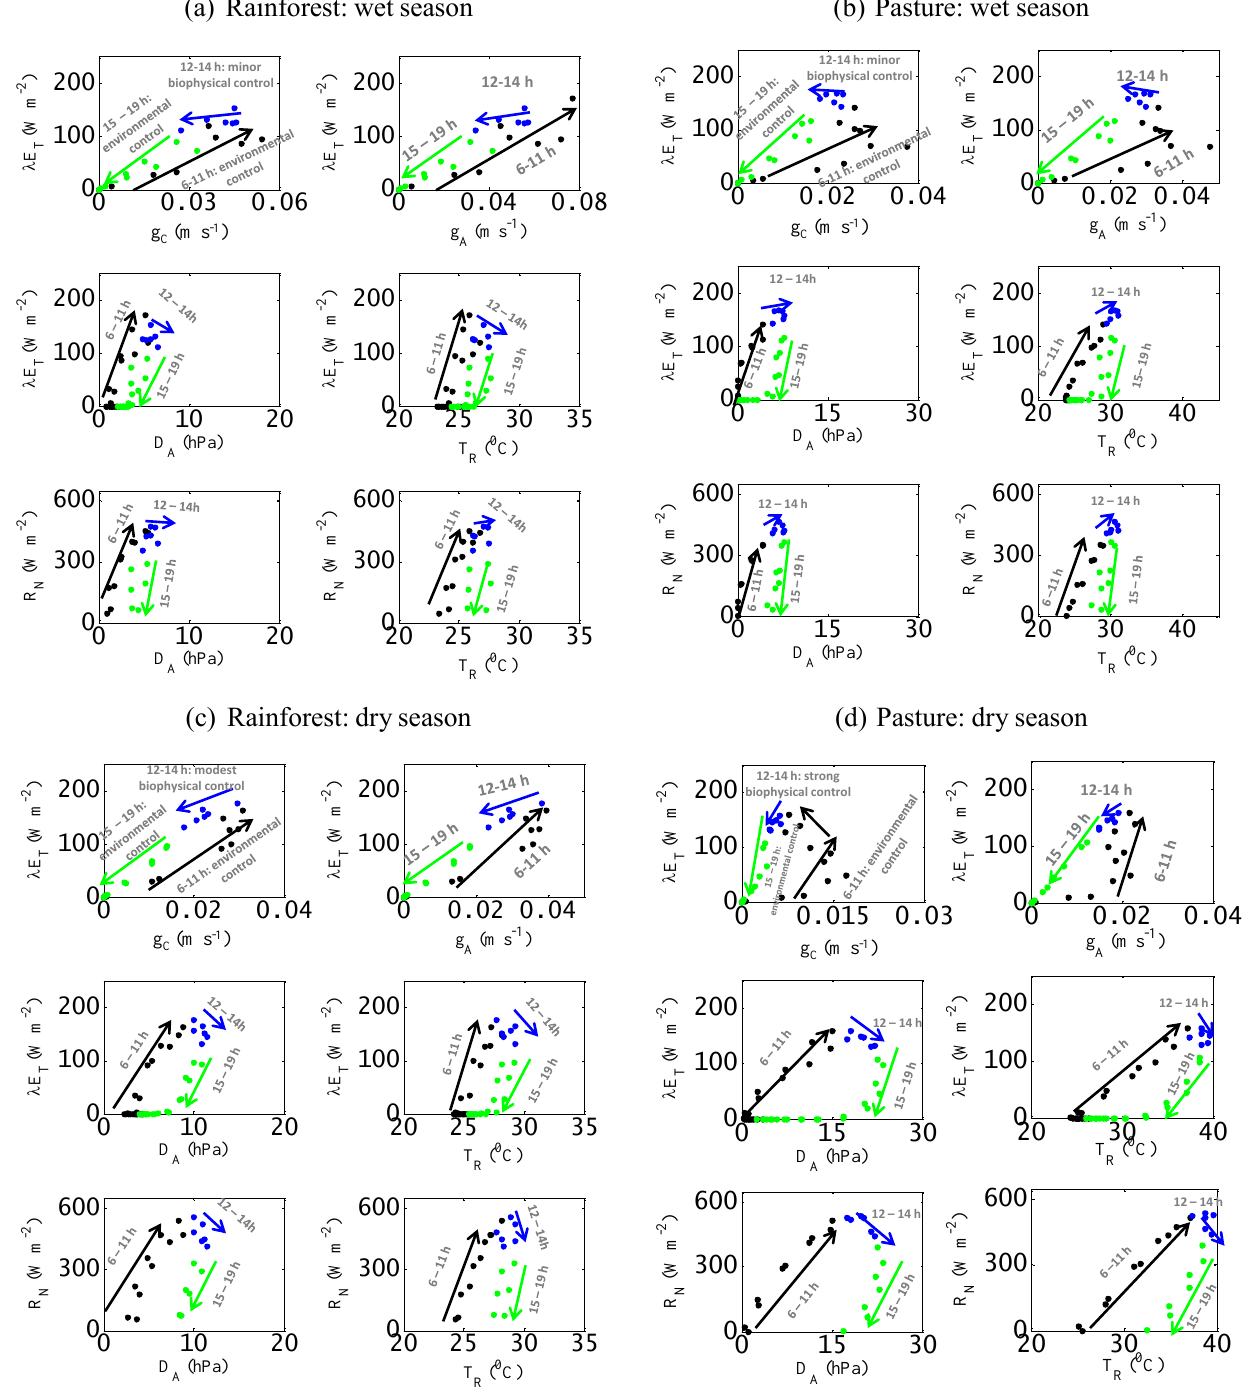
Figure 7. Illustrative examples of the occurrence of diurnal hysteresis of transpiration ( λE T ) during wet and dry seasons with canopy and environmental controls over two different sites with different annual rainfall (2329 and 1597mm, respectively) in the Amazon Basin (LBA tower sites K34 and